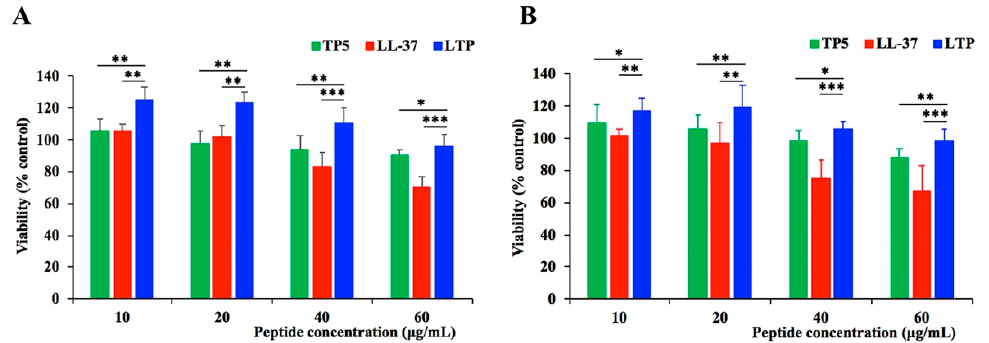
Figure 1. Cell proliferation rates of RAW264.7 cells in the absence or presence of hybrid peptide and parental peptides. RAW264.7 cells were pre-seeded in DMEM medium overnight. The cells were